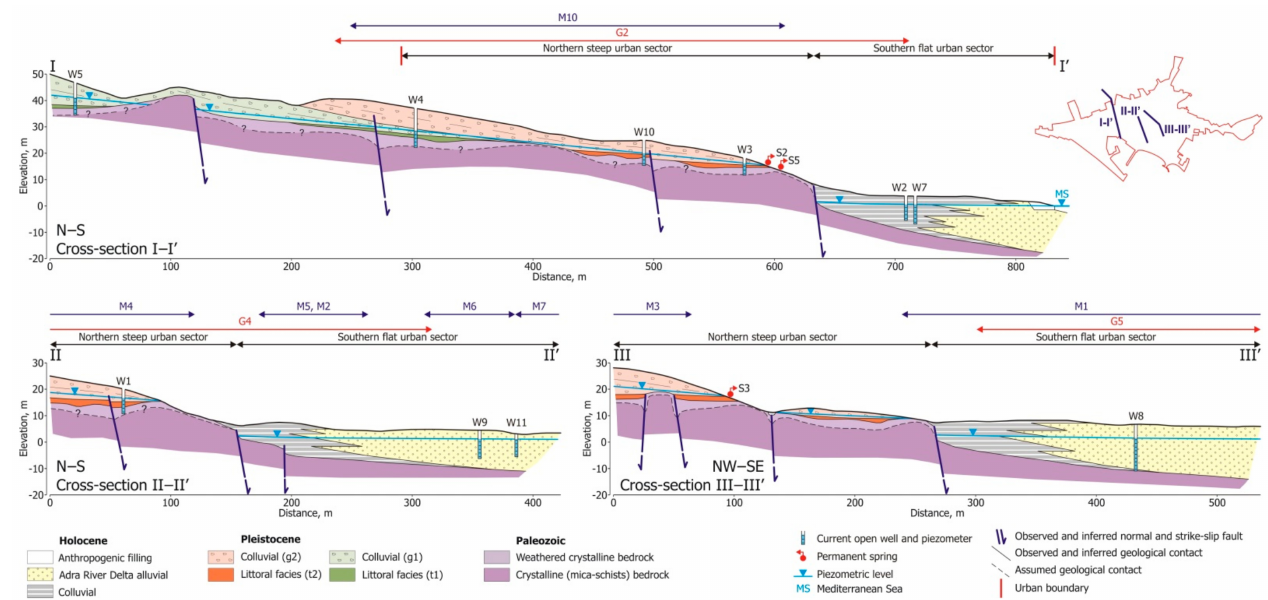
Figure 7. Three hydrogeological cross-sections I–I’, II–II’, and III–III’ (see location in Figure 6), showing the distances covered by MASW (double sided arrow blue lines) and GPR (double sided arrow red lines) sections, operative and historical groundwater observation points, and the projected piezometric level after the flash campaign carried out in June 2015. Cross sections are topographically corrected, and its vertical-to-horizontal scale ratio is